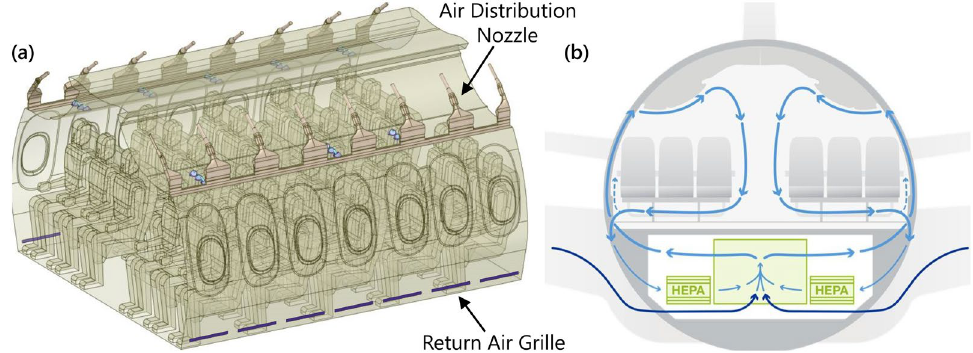
Figure 1. Airflow design in narrow-body aircraft. ( a ) Airflow delivery features in the 737 Boeing Sky Interior cabin used in simulations. ( b ) Idealized airflow pattern in the passenger